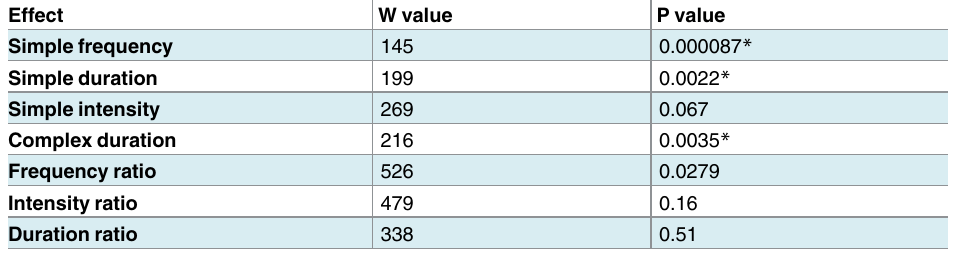
Table 3. Mann-Whitney-Wilcoxon test for perceptual effects between musicians and